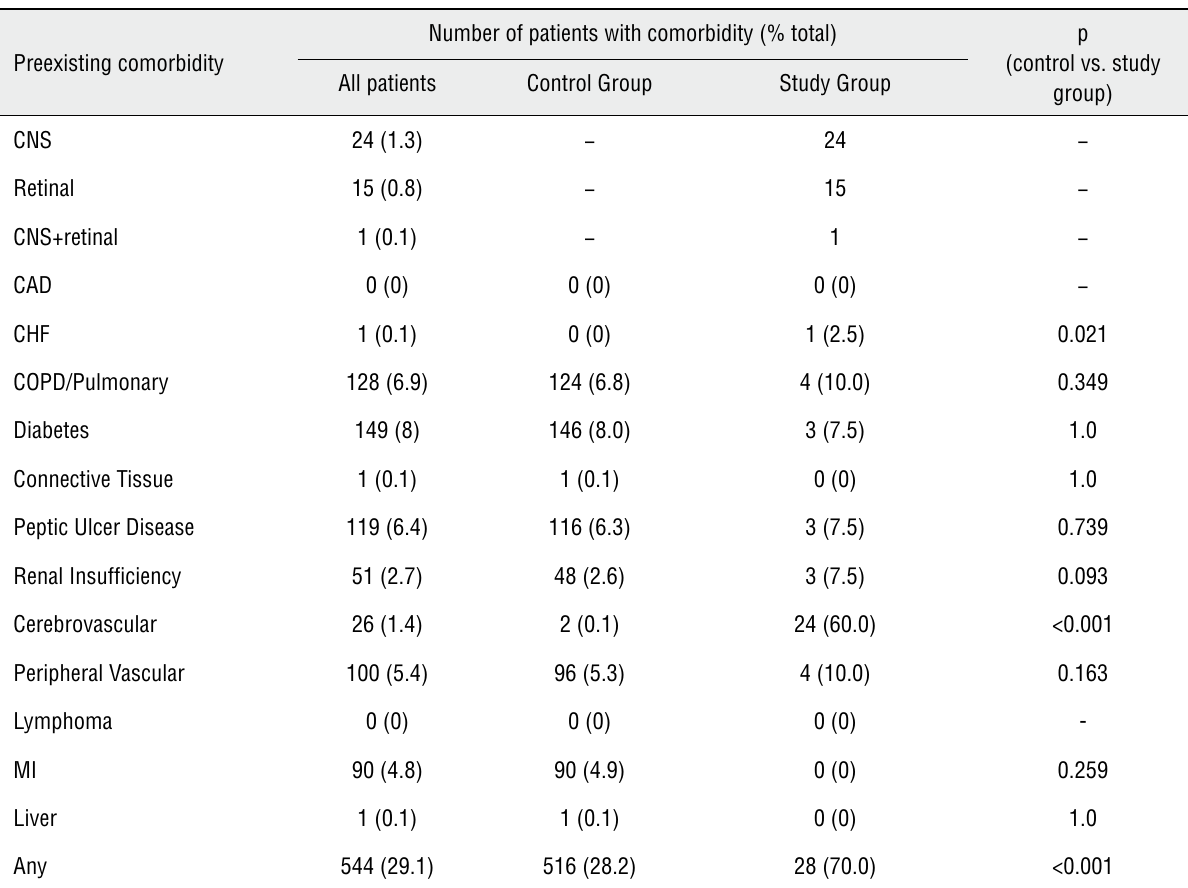
Table 2 - Retinal and CNS-related comorbidities of patients who underwent RALP. Number of patients with comorbidity (% total) p Preexisting comorbidity